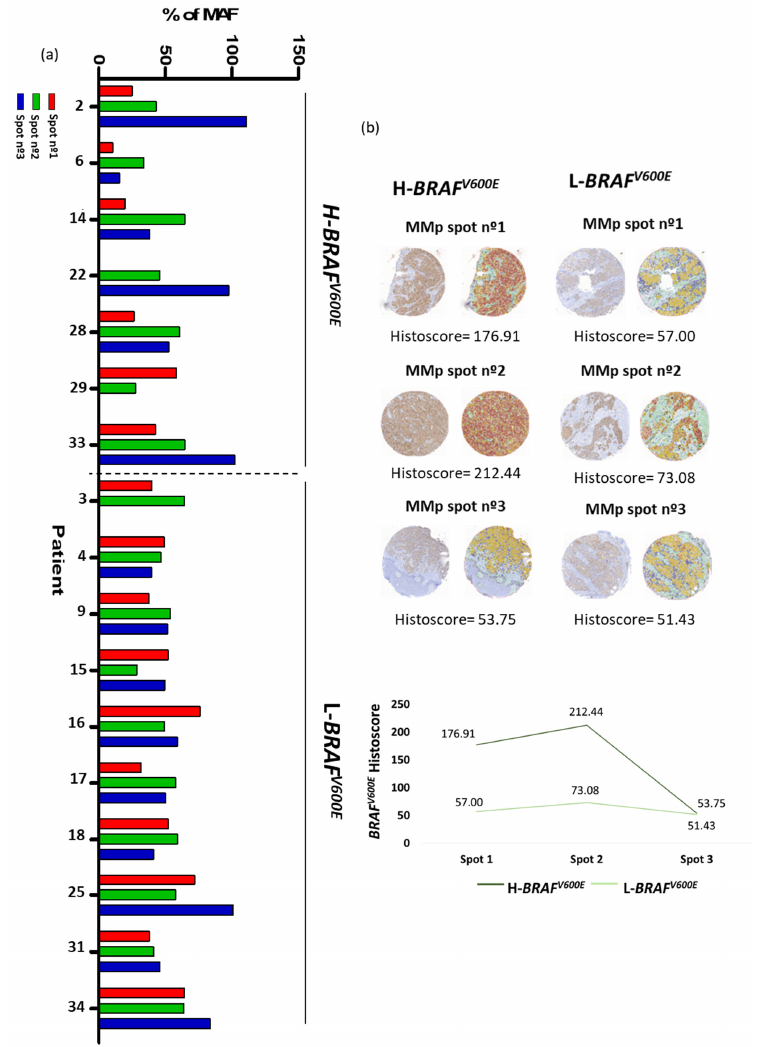
Figure 2. MAF of BRAF V600E ( a ) NGS analysis of BRAF V600E MAF corrected by % of tumor cells. Patients grouped in H- BRAF V600E and L- BRAF V600E . ( b ) Immunohistochemical examples of primary melanoma tumor with high immunohistochemical histoscore variation of BRAF V600E between its spots and primary melanoma tumor with low immunohistochemical histoscore variation of BRAF V600E between its spots.